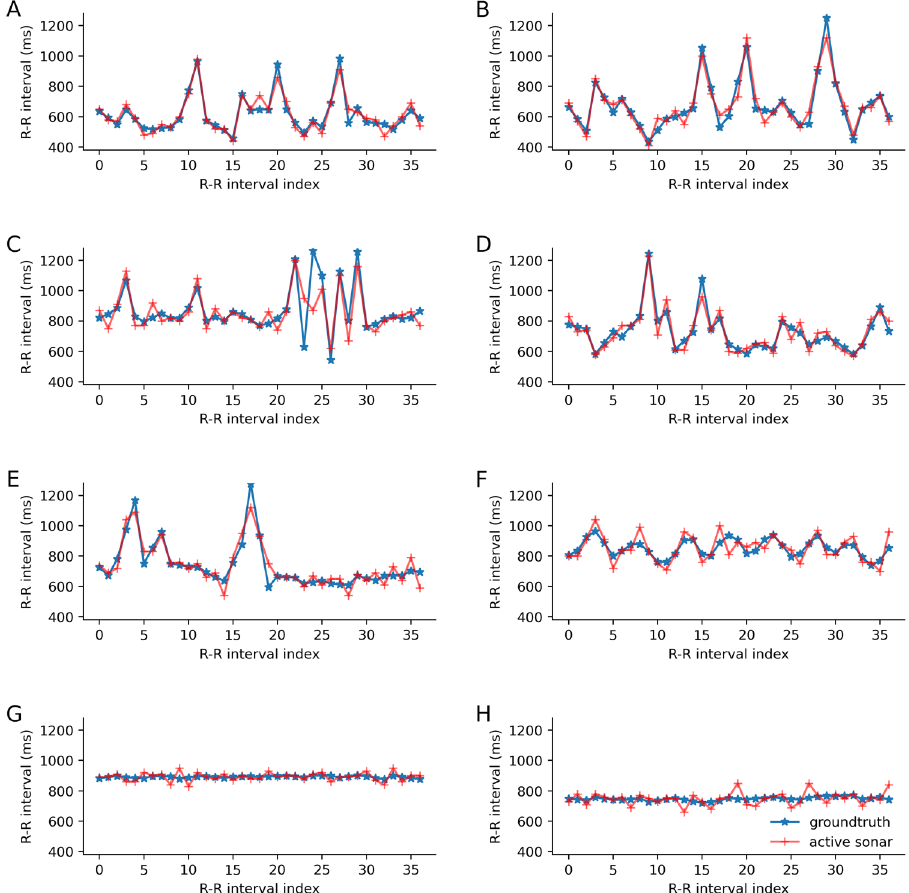
Fig. 6 Example plots showing the time series of R – R intervals for cardiac patients, where red and blue lines represent our active sonar system and ground truth, respectively. A – E fi ve atrial fi brillation patients, F a patient with respiratory arrhythmia, and G , H two patients with sinus rhythm without